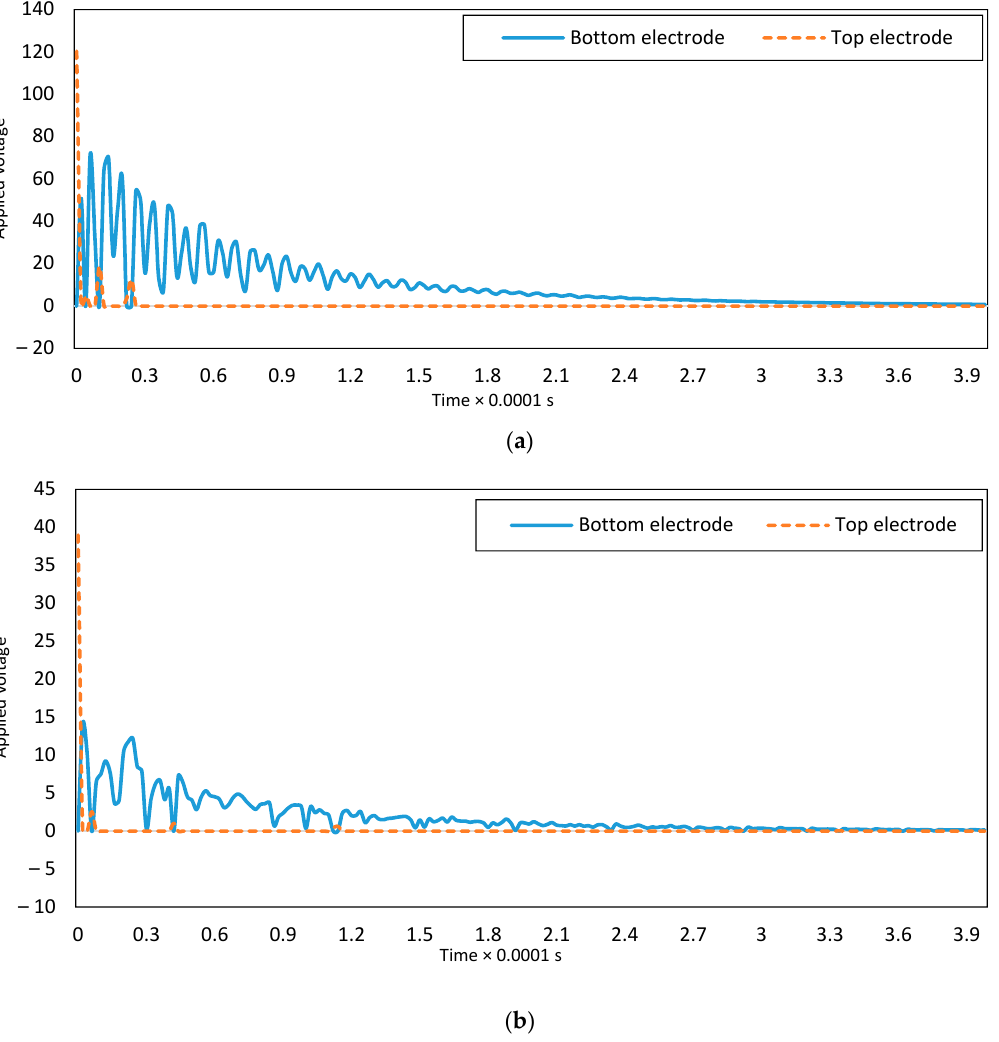
Figure 5. Supplied voltage of two electrodes for: ( a ) clamped-clamped and ( b ) clamped-free boundary conditions.